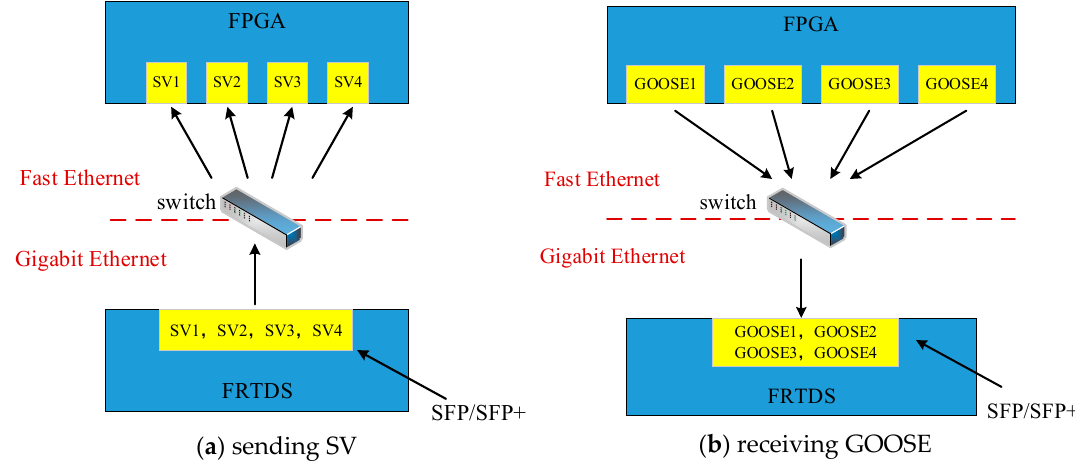
Figure 9. Communication test scheme. ( a ) Sending SV; ( b ) receiving GOOSE.